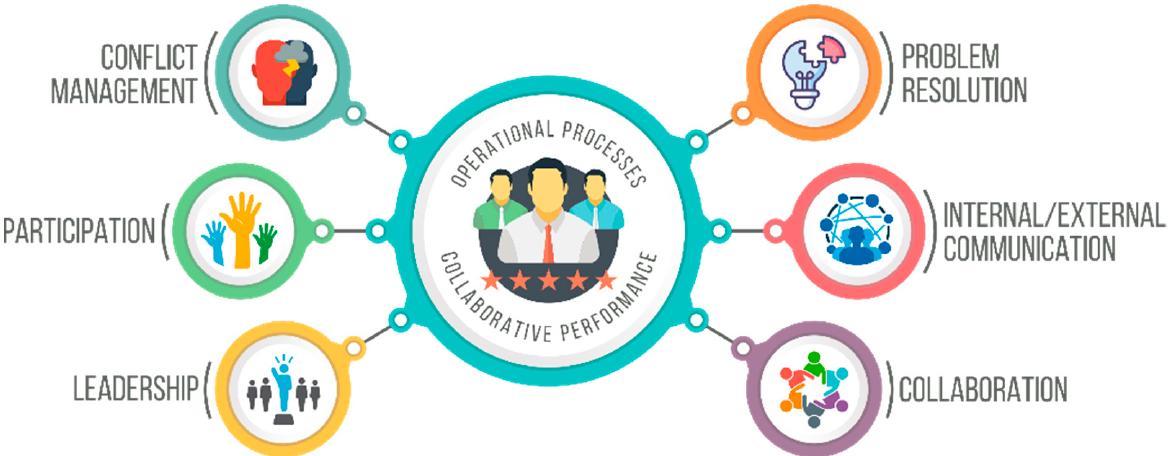
Figure 1. Operational processes of the tool by Diez et al. [17].